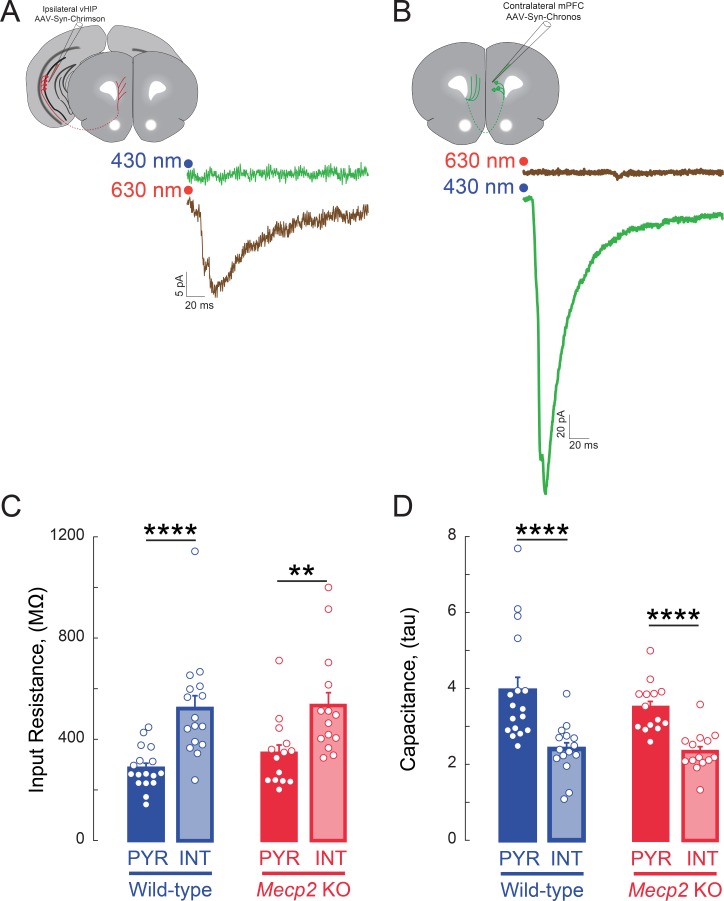
Specific activation of axons expressing opsins with non-overlapping light sensitivity.(A) EPSCs evoked by red light (630 nm) in a layer 5 mPFC neuron in a slice from a mouse with Chrimson injection in the vHIP; the same neuron did not respond to blue light (430 nm). (B) EPSCs evoked by blue light (430 nm) in a layer 5 mPFC neuron in a slice from a mouse with Chronos injection in the c-mPFC; the same neuron did not respond to red light (630 nm). (C) Input resistance and (D) whole-cell capacitance of visually identified pyramidal neurons and interneurons in layer 5 of mPFC (n = 17 pyramidal neurons from 8 slices from 8 WT mice, 15/8/8 WT interneurons, 14/5/5 Mecp2 KO pyramidal neurons, 14/8/8 Mecp2 KO interneurons; p=0.0002 WT pyramidal vs. interneuron input resistance, p=0.0035 Mecp2 KO pyramidal vs. interneuron; Interaction p=0.5739; Neuron Type p<0.0001; Genotype p=0.4085; Two-Way ANOVA with Benjamini and Hochberg Multiple Comparisons; p<0.0001 WT pyramidal vs. interneuron capacitance, p=0.0018 Mecp2 KO pyramidal vs. interneuron; Interaction p=0.4428; Neuron Type p<0.0001; Genotype p=0.3026; Two-Way ANOVA with Benjamini and Hochberg Multiple Comparisons). The whole-cell capacitance was estimated from the time constant of the exponential decay of the current response to a test voltage step. Mean ± SEM; *p<0.05, **p<0.01.10.7554/eLife.44182.041Figure 8—figure supplement 1—source data 1.vHIP synapses on mPFC layerfivepyramidal neurons are stronger in Mecp2KO mice.